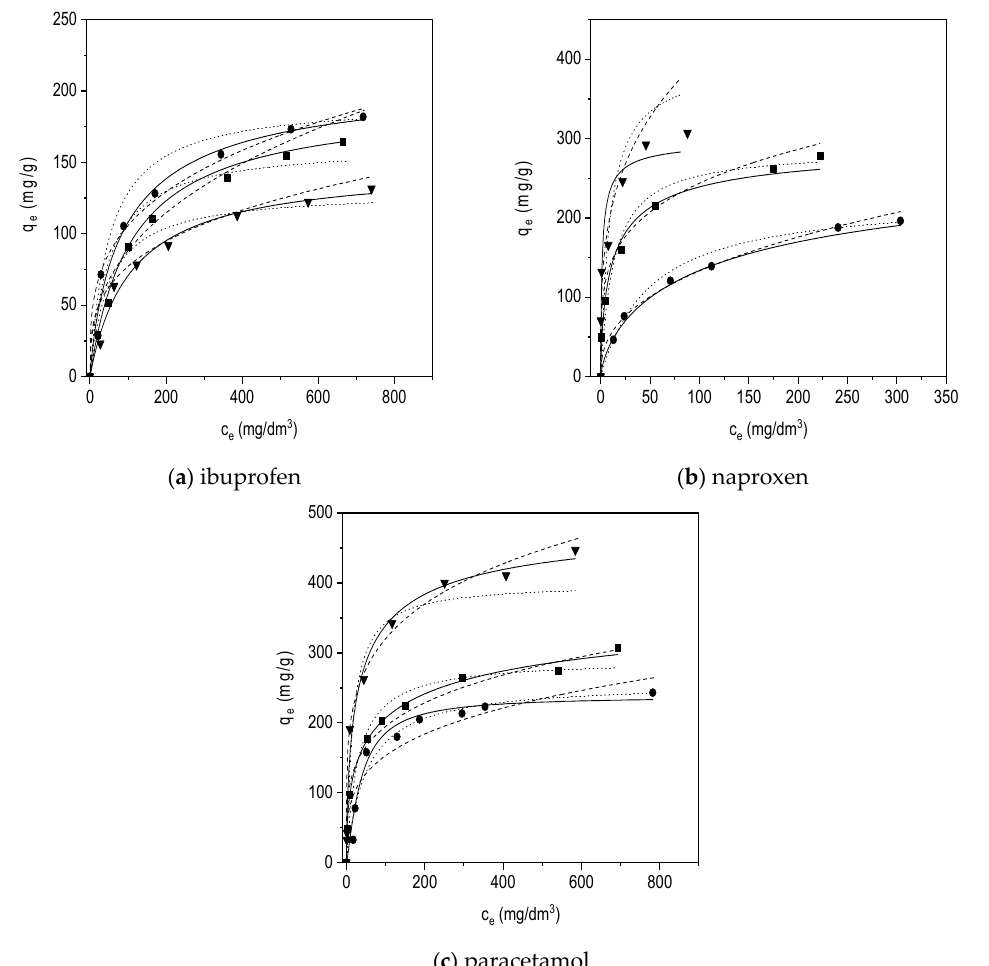
Figure 7. Calculation of adsorption equilibrium constant for ibuprofen, naproxen, and paracetamol onto adsorbents: (cid:4) —ST-A-P; (cid:72) —ST-A-P-CO 2 ; (cid:8) —WG-15 employing the experimental data. The full line represents the curve obtained by the application of the Langmuir–Freundlich equation; dash line reflects the Freundlich equation, whereas drop line corresponds to the Langmuir one with respect to the adsorption data as adjusted by the least-squares method. Table 8. Langmuir, Freundlich, and Langmuir-Freundlich equations parameters and correlation coefficients R 2 for the adsorption of the studied paracetamol on adsorbents.